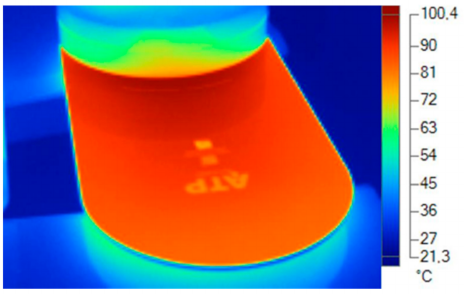
Figure 20. Thermal data of the heatsink. Reddish area: emissivity aluminum alloy 0.5. Source: Software SmartView 4.1